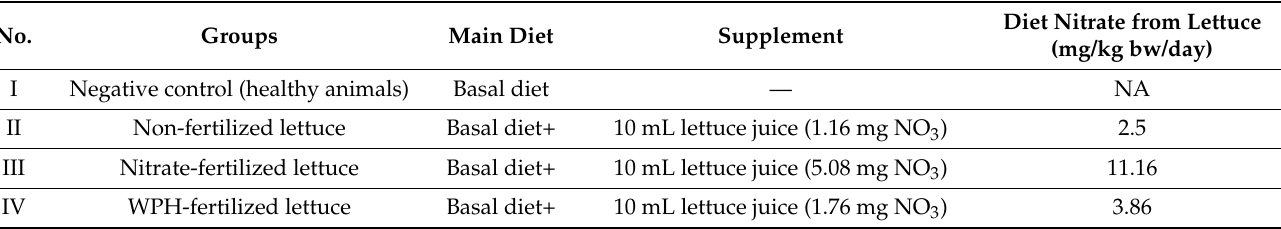
Table 2. Experimental design for rabbit administered standard basal diet plus lettuce juice prepared from nonfertilized, nitrate-fertilized, and whey proteins hydrolysate (WPH)-fertilized lettuce fortified basal diet as compared to that of negative control, i.e., uniquely receiving basal